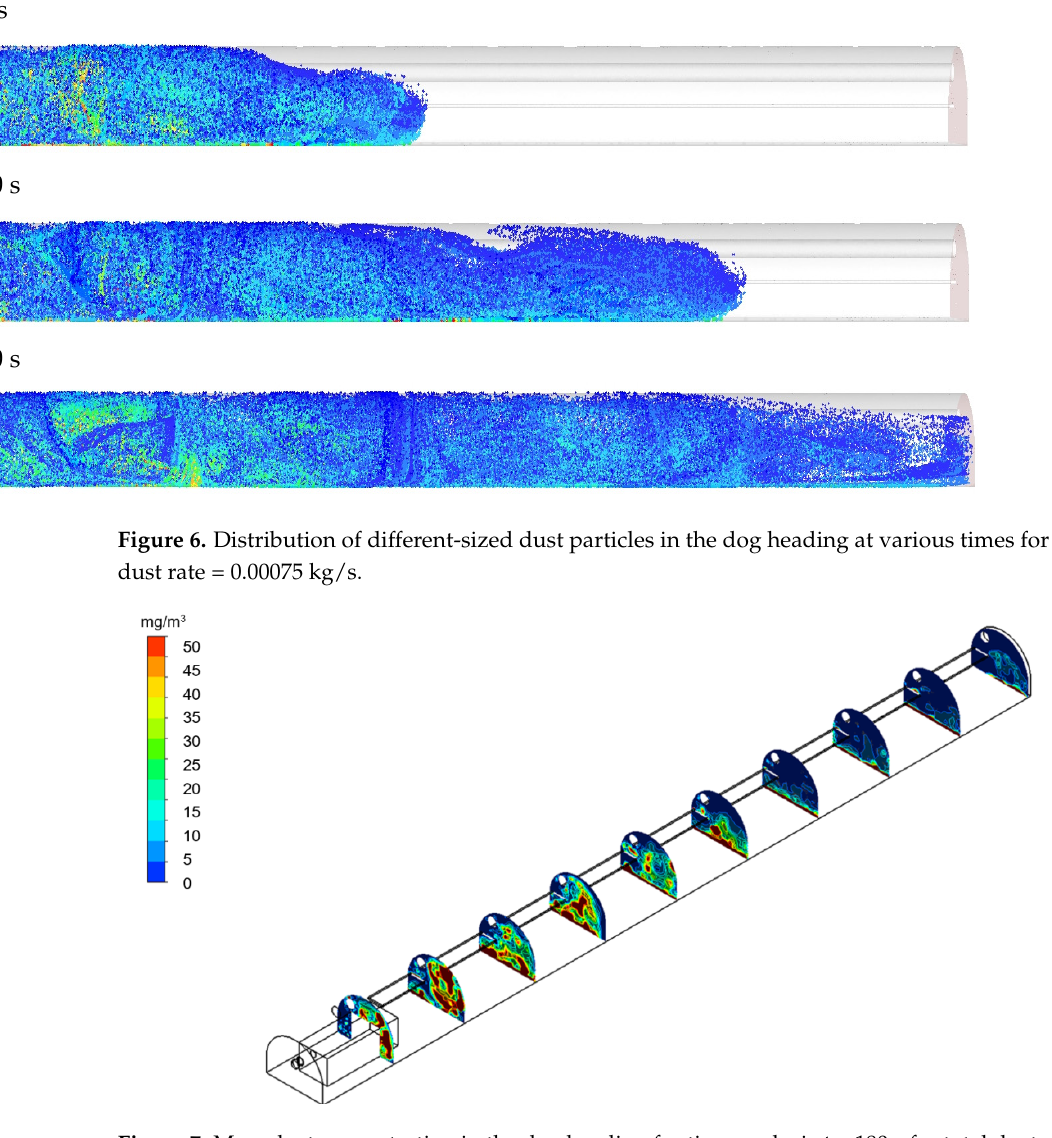
Figure 7. Mass dust concentration in the dog heading for time analysis t = 180 s for total dust rate = 0.00125 kg/s.